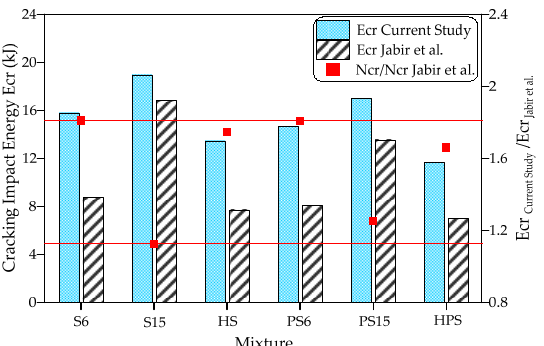
Figure 14. Comparison of cracking impact energy Ecr values of Jabir et al. [67] with those of the current study.